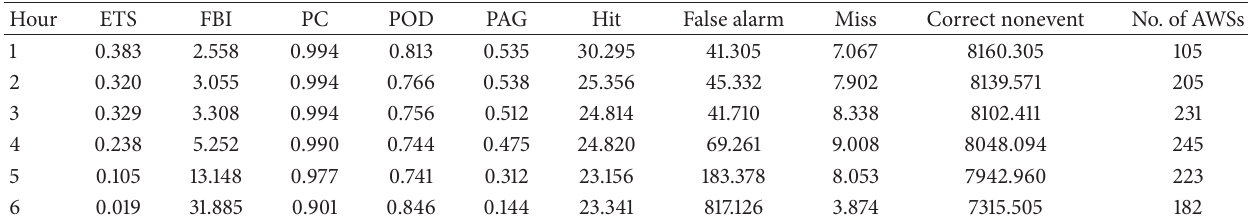
Table 9: Results of DE with SVM from 1 to 6 hours (WP).